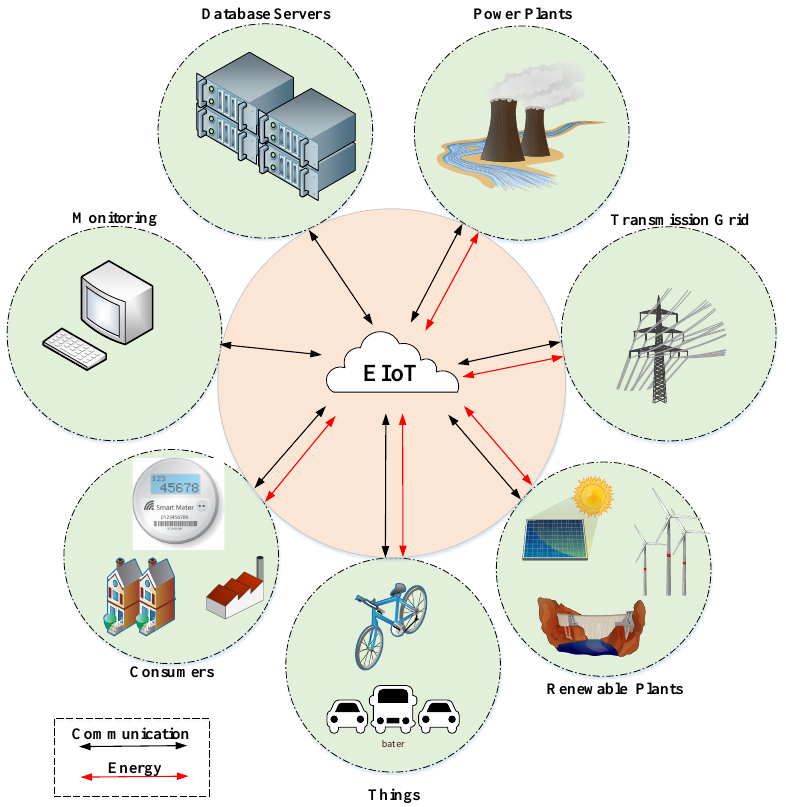
Figure 1. The Energy Internet of Things (EIoT)